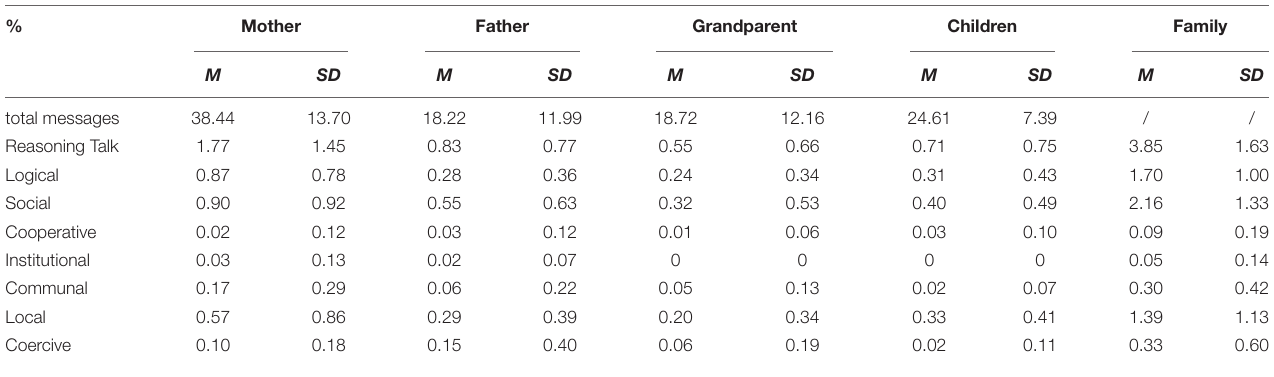
TABLE 2 | Descriptive statistics of the proportion of reasoning talk generated by the participating family members.